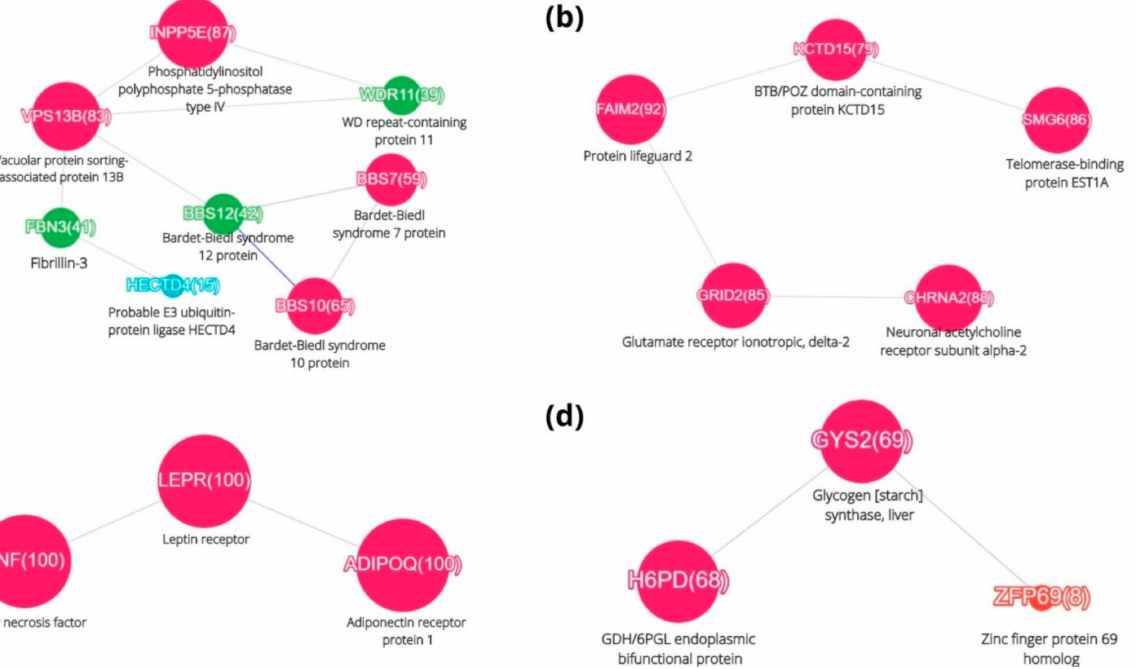
Figure 3. Four clusters of the obesity-relevant semantic network. Clusters ( a – d ) were obtained as a result of comparing data from the DisGeNET expert system and the results of automatic processing of abstracts of scientific publications in ScanBious, with a threshold value of the Jaccard index > 0.2, with the condition that there were at least five articles for the object being visualized as a network